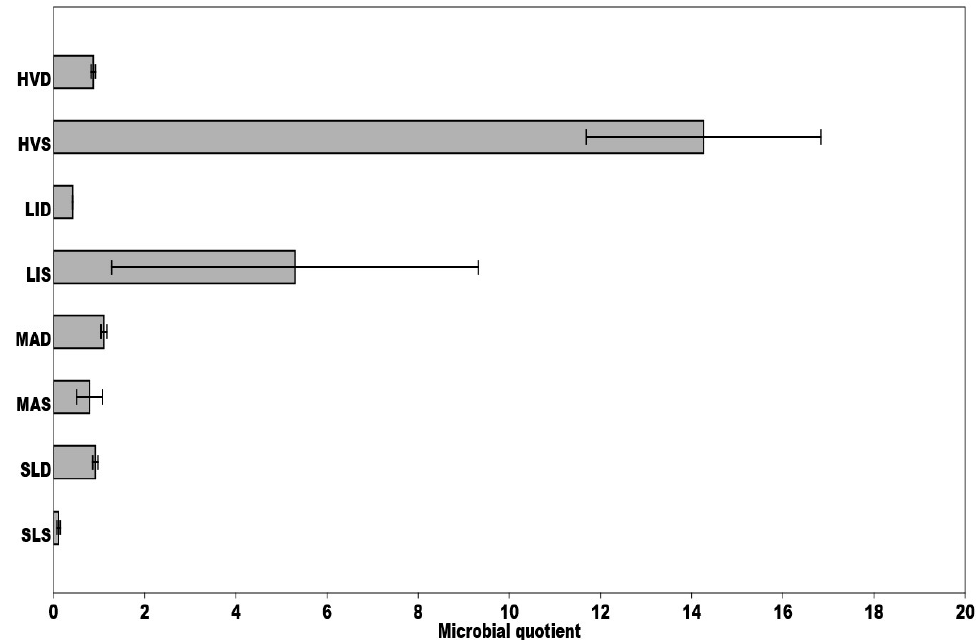
Figure 4. Comparison of mean microbial quotients calculated for each site, during the sampling period, respectively; qMic (MBC/Corg)-the ratio of microbial biomass carbon (mg C/g) to soil organic carbon. Means ± standard deviation (SD) are presented.